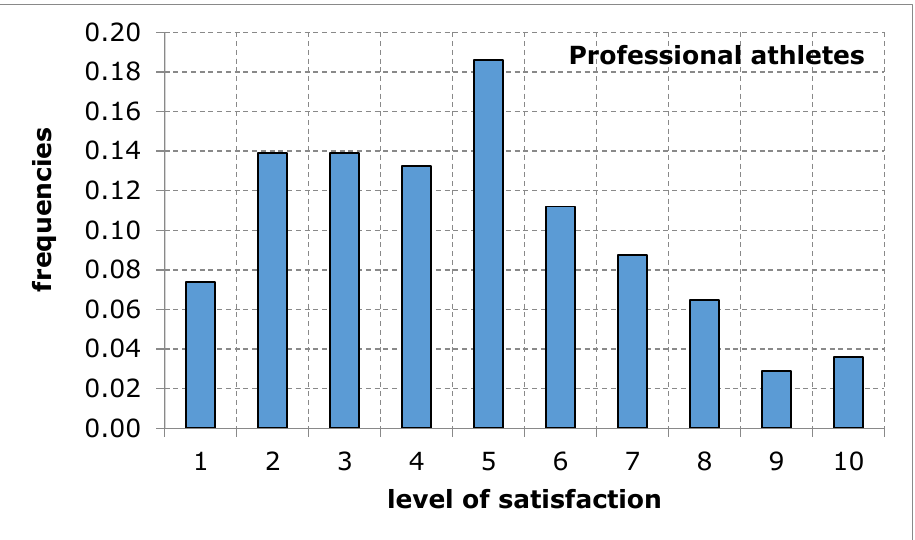
Figure 10. Use of a sports and recreation facility for competitive sport purposes, in the opinion of service recipients (professional athletes). Source: own work.